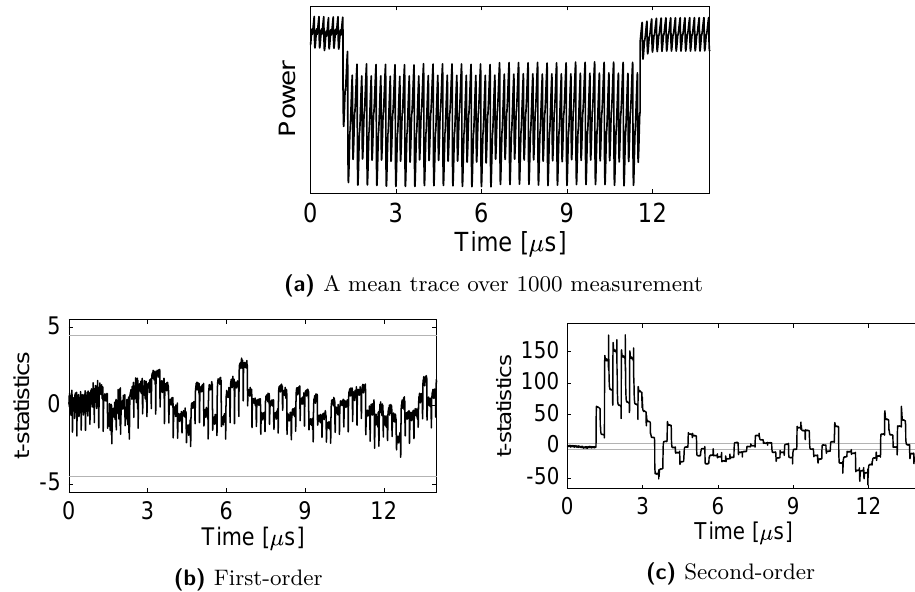
Figure 6: Experimental analysis of our first-order PRESENT nibble-serial encryption design (covering the first five rounds); fixed vs. random t-test results using 100 million traces.